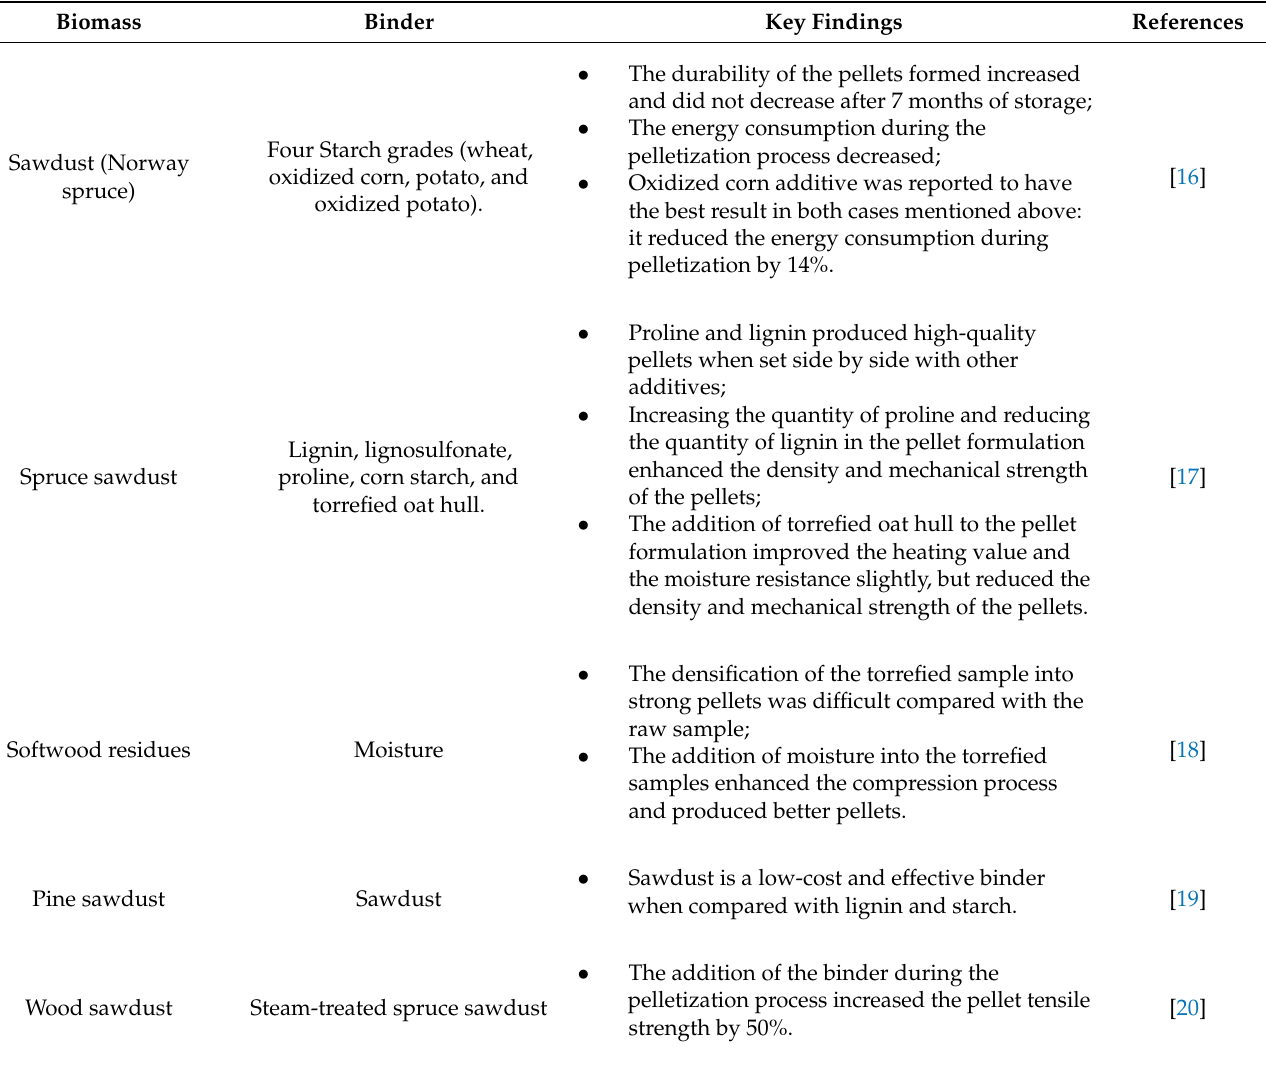
Table 1. Effect of binders on the pelletization of biomass, as determined by other researchers. Biomass Binder Key